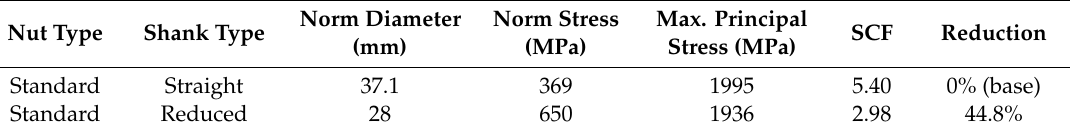
Table 8. Bolt shank effect on SCF (connected with standard nut type).